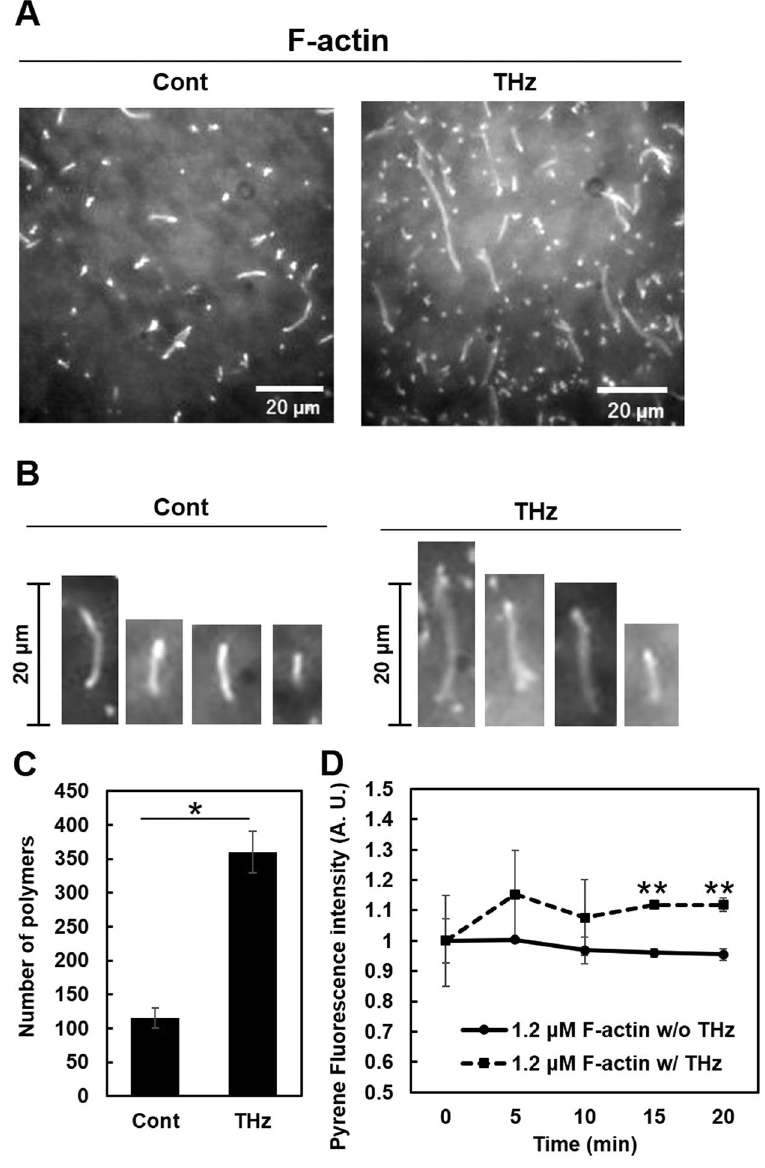
Figure 4. Effect of THz irradiation on actin filaments. G-actin solution (0.8 μ M) was polymerized by adding F-actin buffer with or without THz irradiation (THz or Cont, respectively) for 20 min. ( A ) Magnified images of actin filaments with or without THz irradiation. Bar: 20 μ m. ( B ) Comparison of the morphology of actin filaments between the control and the THz-irradiated samples. Bar: 20 μ m. ( C ) Comparison of the number of actin filaments between the control and THz-irradiated samples. Relative numbers are shown with the control sample as 1.0. Date shown are the mean ± SD of three independent experiments. More than 100 actin filaments were counted in each of the experiments. * P < 0.05. ( D ) Pyrene actin filaments were formed for 1 h and then fluorescence was measured at each time with or without THz irradiation (w/THz or w/o THz, respectively). The relative fluorescence of pyrene at 0 min was defined as 1.0. Data shown are the mean ± SD of three independent experiments. ** P <